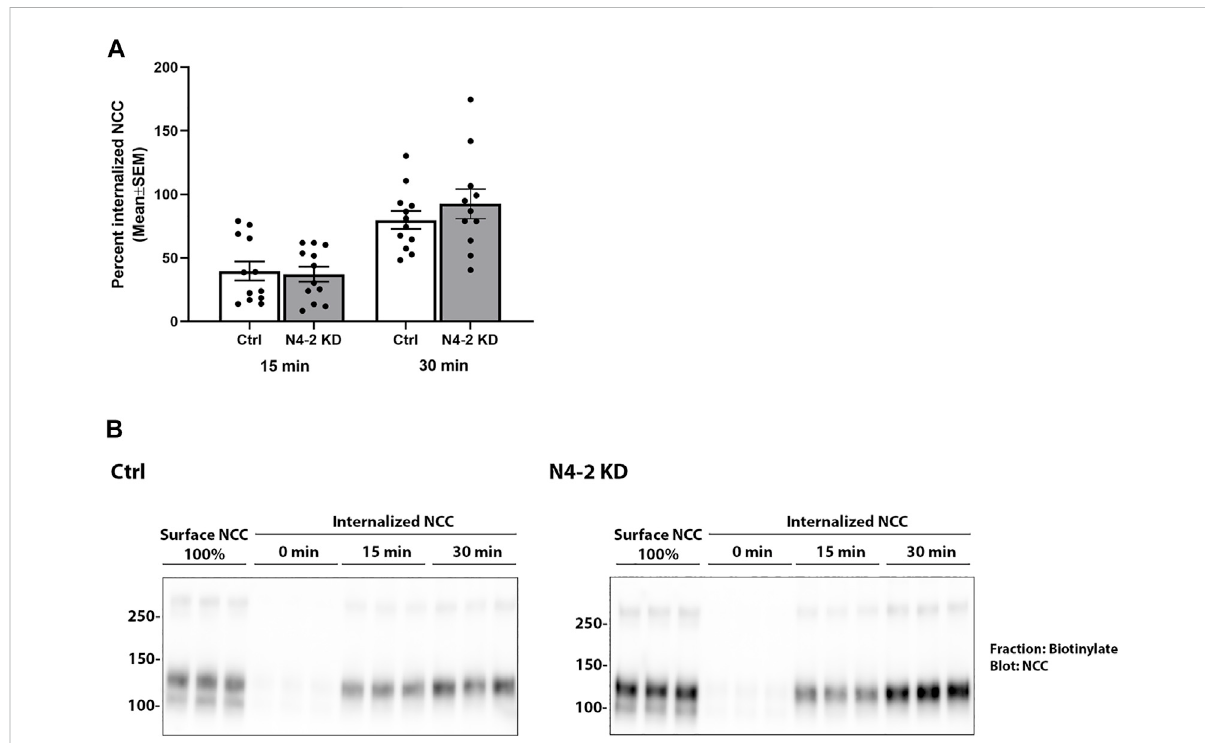
FIGURE 6 Nedd4-2 de fi ciency does not change the constitutive internalization of NCC from the apical plasma membrane in MDCKI-hNCC cells. (A) Semi-quantitative assessment of the percentage of internalized NCC (steady-state surface levels equals 100%) at 15 and 30 min. Data are means ± S.E.M. ( n = 12). Signi fi cance is assessed with 2way ANOVA followed by Tukey ’ s multiple comparisons test. (B) Representative blots showing NCC internalization. Following biotinylation, MDCKI-hNCC Ctrl and Nedd4-2 (N4-2) KD cells were incubated for 15 or 30 min at 37 ˚ C to allow membrane protein internalization before treatment with the reducing agent MesNa (stripping biotin). Lane 1-3 show expression of steady-state surface NCC. Lane 4-6 show surface NCC after treatment with the stripping agent MesNa. Internalized NCC was isolated, detected by western blot, and quanti fi ed by densitometry.